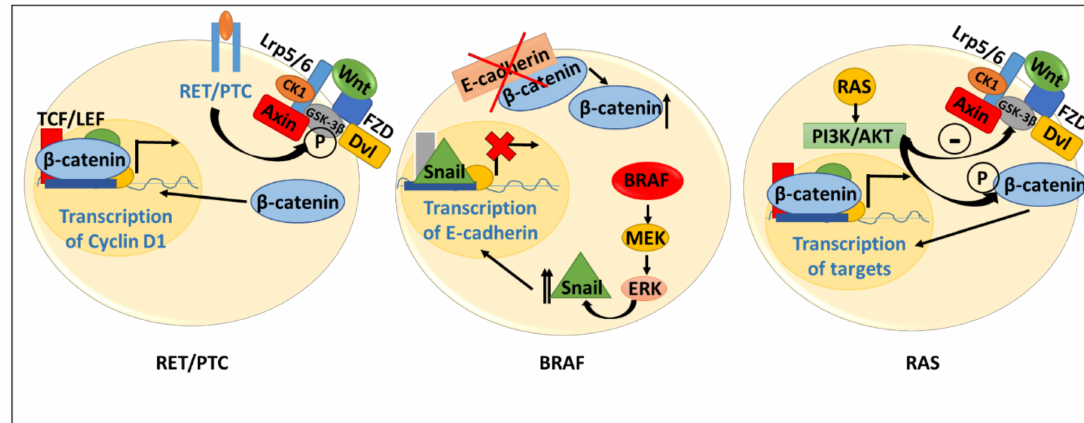
Figure 4. Proposed role of Wnt signaling in current papillary thyroid carcinomas (PTCs) with common driver mutations/alterations. In tumors with RET/PTC fusions, RET/PTC promotes the stabilization of β -catenin though phosphorylation of GSK-3 β . This allows β -catenin to traffic to the nucleus and interact with TCF/LEF to promote cyclin D1 transcription. In tumors with BRAF V600E mutation, BRAF V600E is constitutively active and its signaling leads to an increased expression of Snail. Snail then acts to inhibit the transcription of E-cadherin by binding to the promoter and acting as a repressor. The decreased E-cadherin expression at the membrane leads to increased cytoplasmic β -catenin. Finally, in RAS-mutated tumors, RAS signaling through PI3K/AKT leads to stabilization of β -catenin through phosphorylation and through inhibition of GSK-3 β . This allows β -catenin to traffic to the nucleus and promote transcription of target